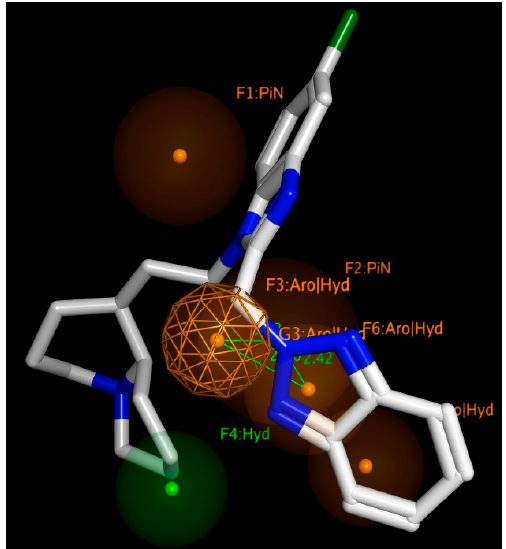
Figure 19. Comparison of the docked pose of 148 with respect to the developed pharmacophore model for RSV F protein inhibitors.